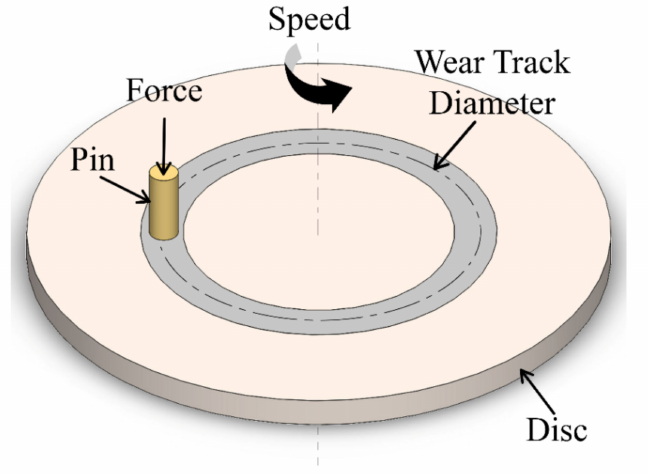
Figure 2. Illustration of pin-on-disc wear test apparatus setup and testing parameters.